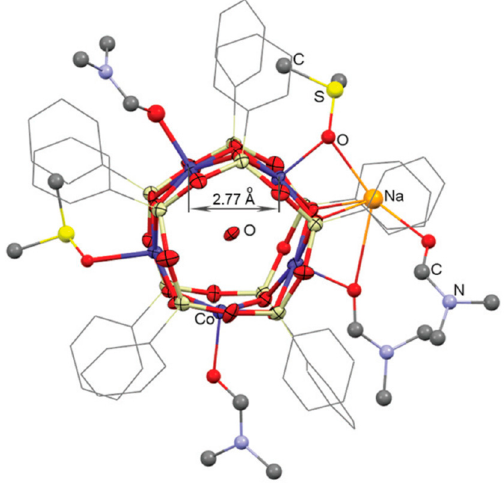
Figure 31. Crystal structure of complex 33 . Color code: Co, blue; Na, orange; Si, light yellow; O, red; C, grey; S, yellow; N, light blue. Adapted from Ref. [165], Copyright (2016) with permission from Royal Society of Chemistry.